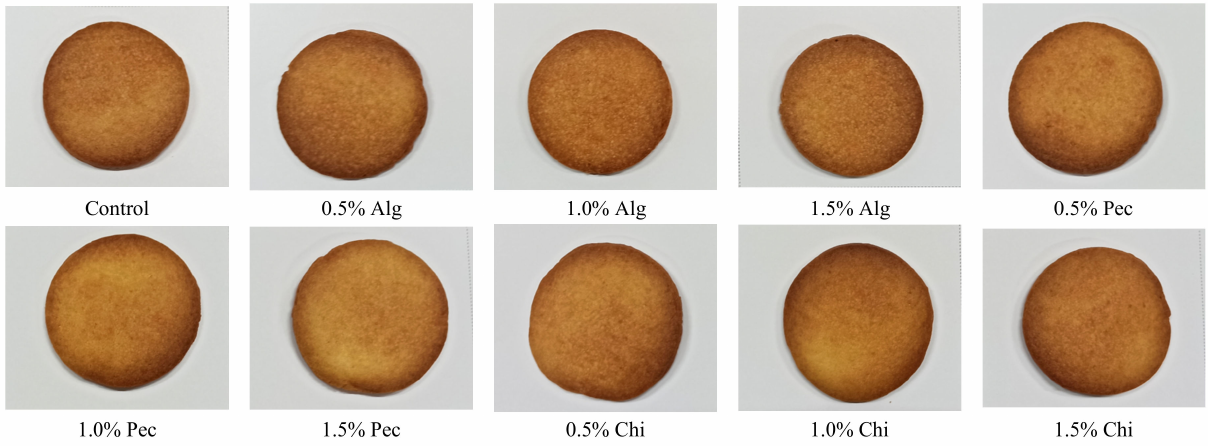
Figure 5. Appearance of biscuits in different formulations. Alg: Sodium alginate; Pec: Pectin; Chi: